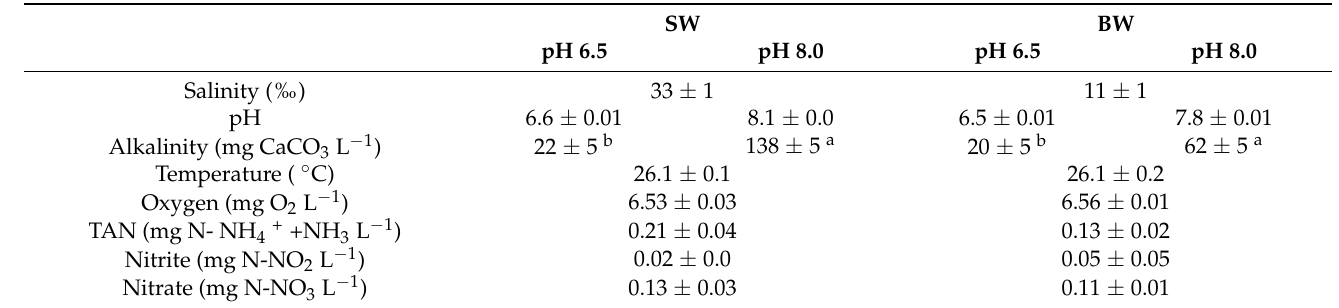
Table 1. Trial 1—water conditions (mean ± standard deviation) for the maintenance of H. reidi (age 0–21 DAR—days after the male’s pouch release) reared in seawater (SW—salinity 33) or